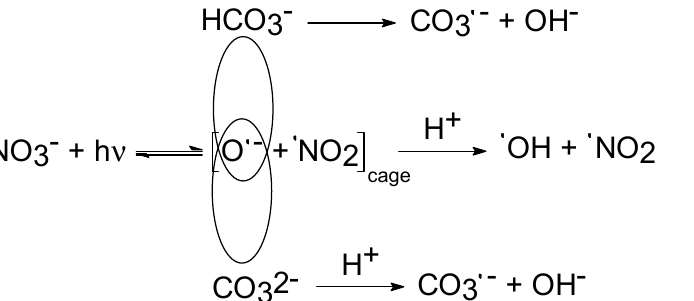
Figure 2. Schematic of the solvent-cage enhancement of nitrate photolysis by HCO 3 − and CO 32 − , which inhibits geminate recombination between the photo-fragments O •− ( • OH precursor) and • NO 2 .